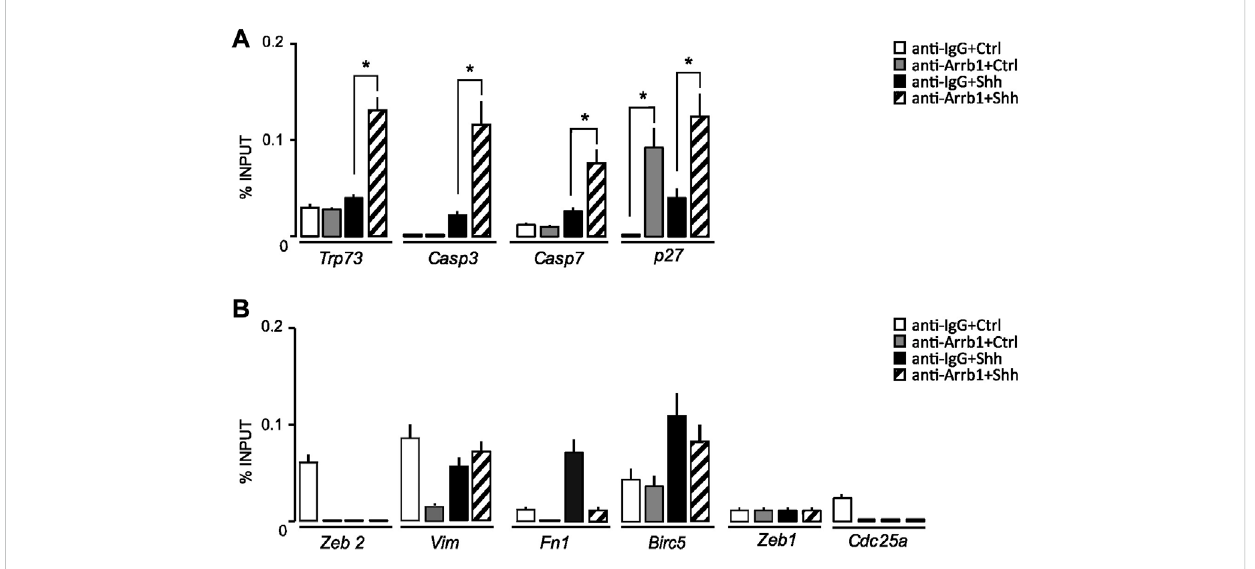
FIGURE 3 ARRB1-E2F1 complex direct regulates the expression of E2F1-ac pro-apoptotic targets. (A,B) qPCR-ChIP assay of ARRB1 in GCPs stimulated or not with Shh. Immunoprecipitation with IgG was performed as control. Eluted DNAwas ampli fi ed by qPCR using primers speci fi cfor theregulatory region of theindicatedgenes. Actin and Gapdh (notshown)wereusedasendogenousnon-enrichedregions.qPCRdataarepresentedaspercentageofChIPinput controls. Data represent means ± S.D., from at least three independent experiments; * p < 0.05; ** p < 0.01; *** p <